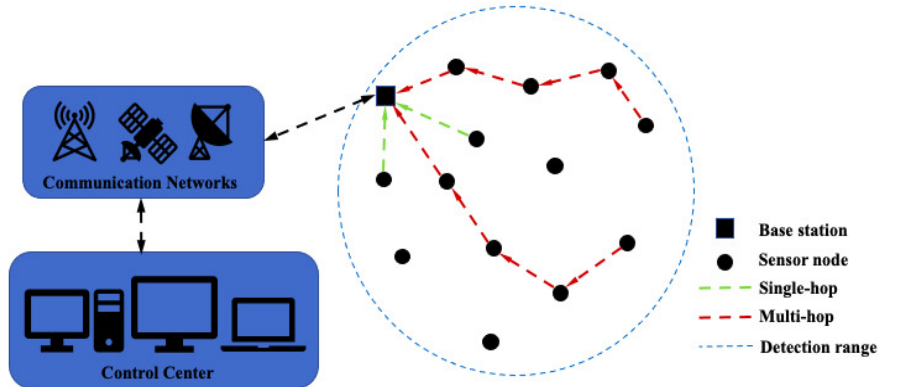
Figure 1. Communication architecture of wireless sensor networks. Table 1. Research on WRSN